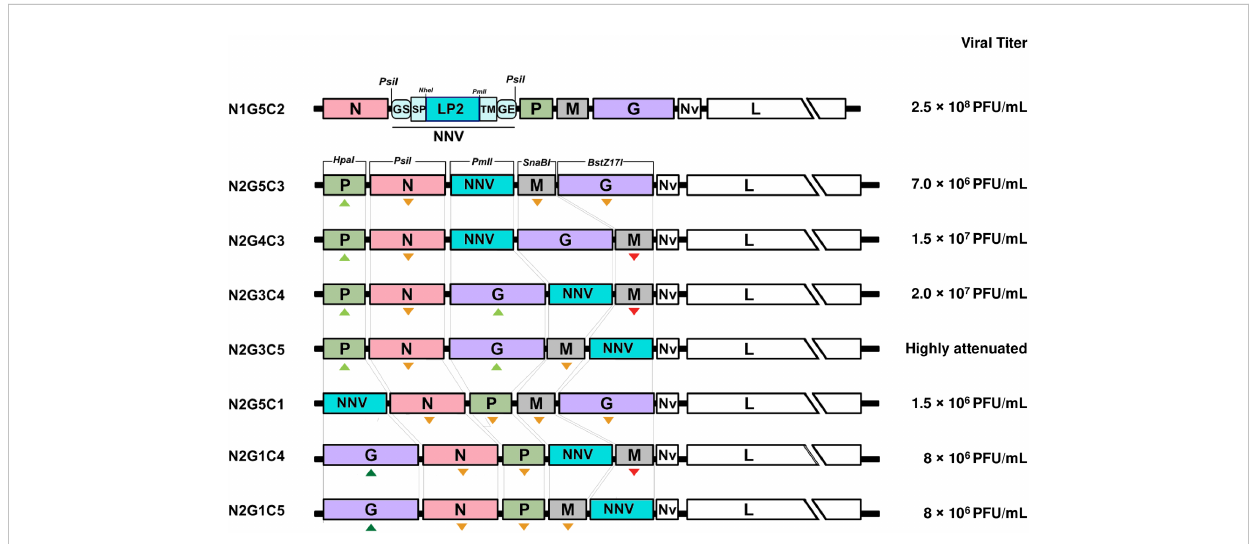
FIGURE 5 Recombinant VHSV expressing NNV epitopes with rearranged genome. Schematic representation of the engineered rVHSV genomes expressing NNV epitopes with rearranged gene order. Nine rVHSV, termed NxGyCz according to the respective positions of the genes encoding the nucleoprotein (N) and glycoprotein (G) as well as the expression cassette (C) along the genome. Viral titers (PFU/mL) obtained after two passages in EPC cells are indicated on the